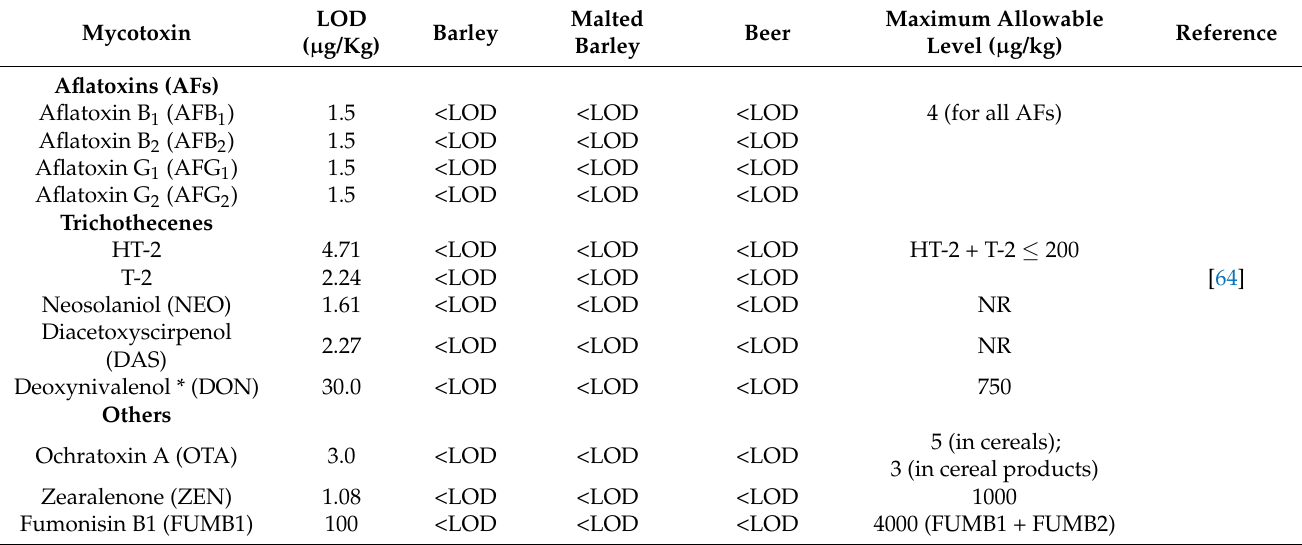
Table 5. Mycotoxin content of the raw materials and